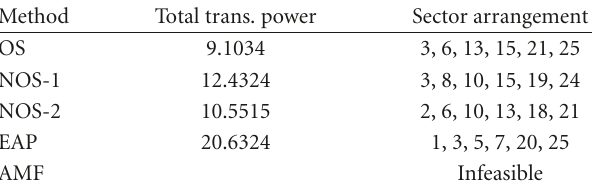
Table 4: Results for the system in Figure 7.